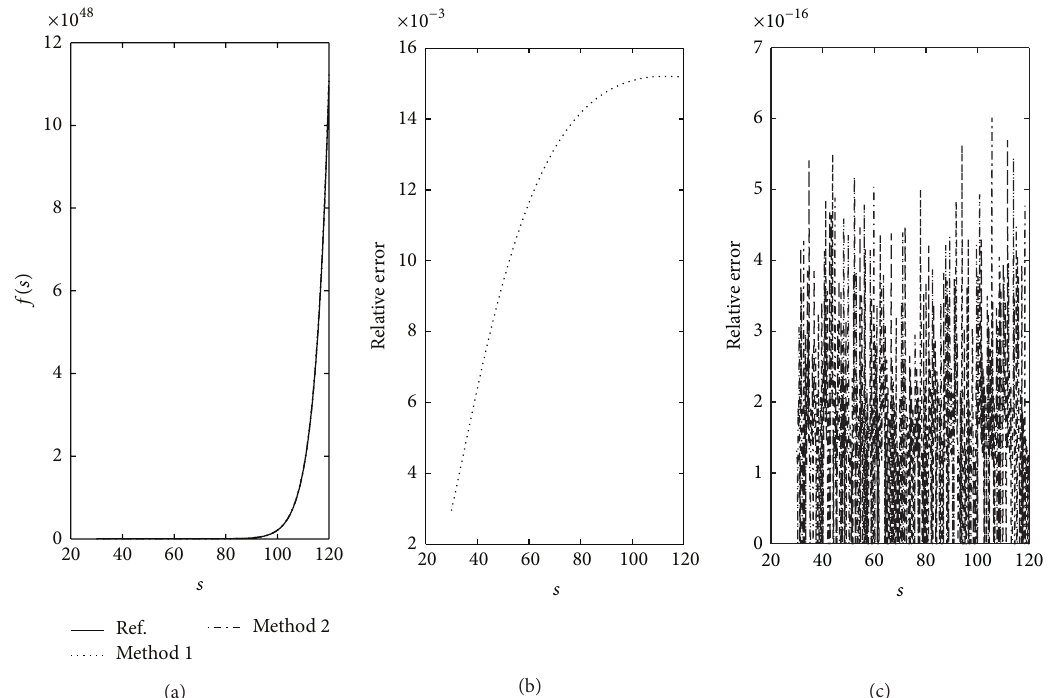
Figure 4: Comparison of expansion results of the proposed methods with reference (a) and relative errors of Method 1 (b) and Method 2 (c) in Example 5.